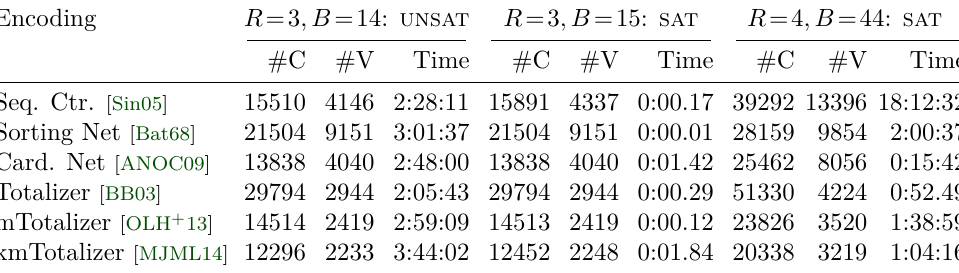
Table 3: Runtime comparison of cardinality encodings of models with #C clauses and #V variables for R -round differential characteristics with #S ≤ B active S-boxes.